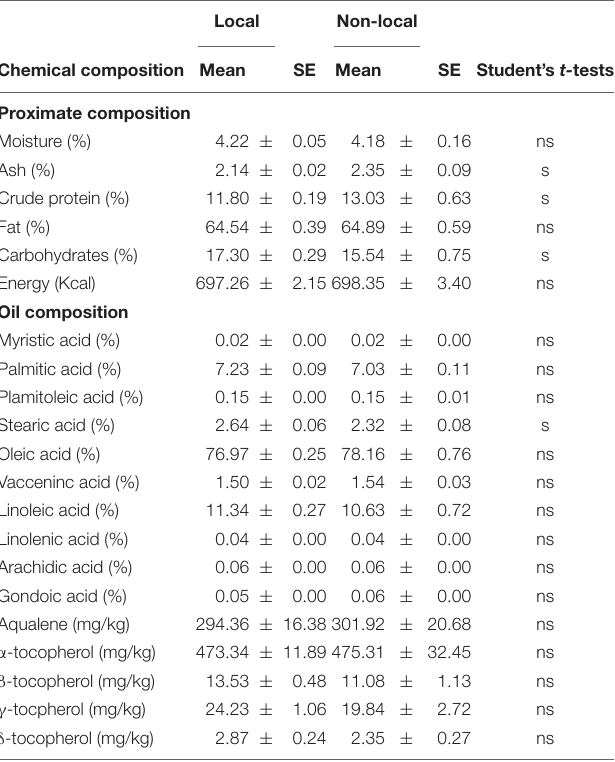
TABLE 3 | Means and standard errors (SE) for chemical characterization of local and non-local accessions at SERIDA in Villaviciosa, Spain.